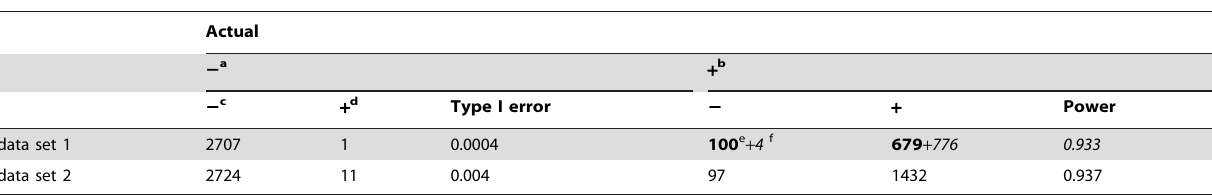
Table 3. Simulation result: Step one of the Two-Step Model (MC_DIST).